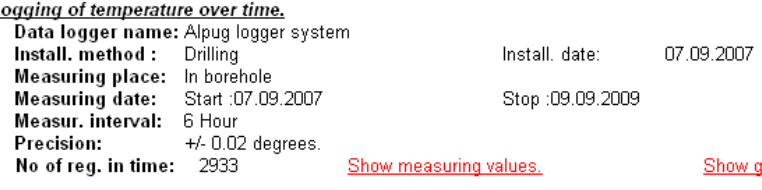
Earth Syst. Sci. Data, 2, 235–246, 2010